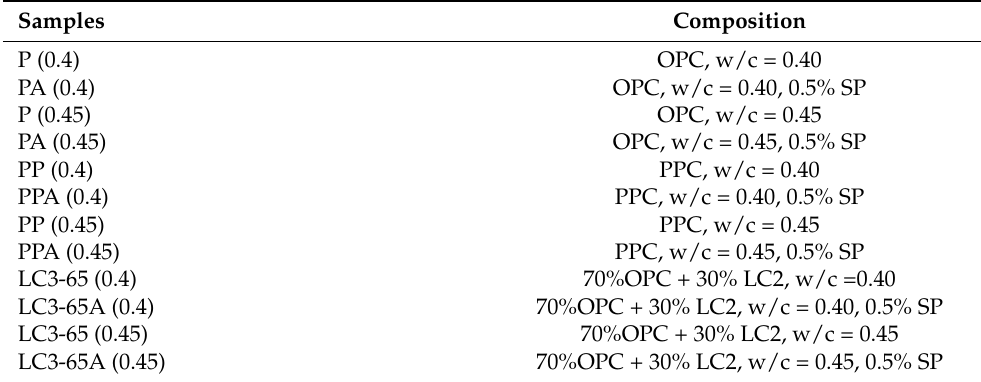
Table 2. Samples in the cement paste.